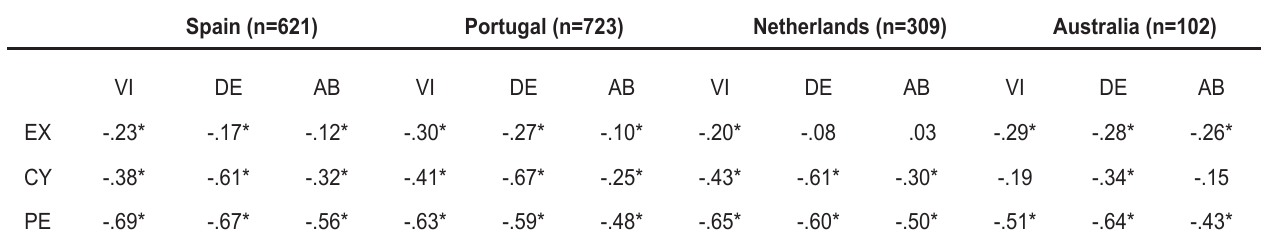
Table 5: Correlations between Maslach Burnout Inventory-Student Survey (MBI-SS) and Utrecht Work Engagement Scale-Student (UWES-S) (adapted from Schaufeli et al., 2002a, p.473) Schaufeli has argued that because student burnout is considered to be an erosion of academic engagement it is expected that all burnout and engagement scales are at least moderately negatively related. According to Schaufeli et al. (2002a), a relatively strong association is particularly expected between exhaustion and